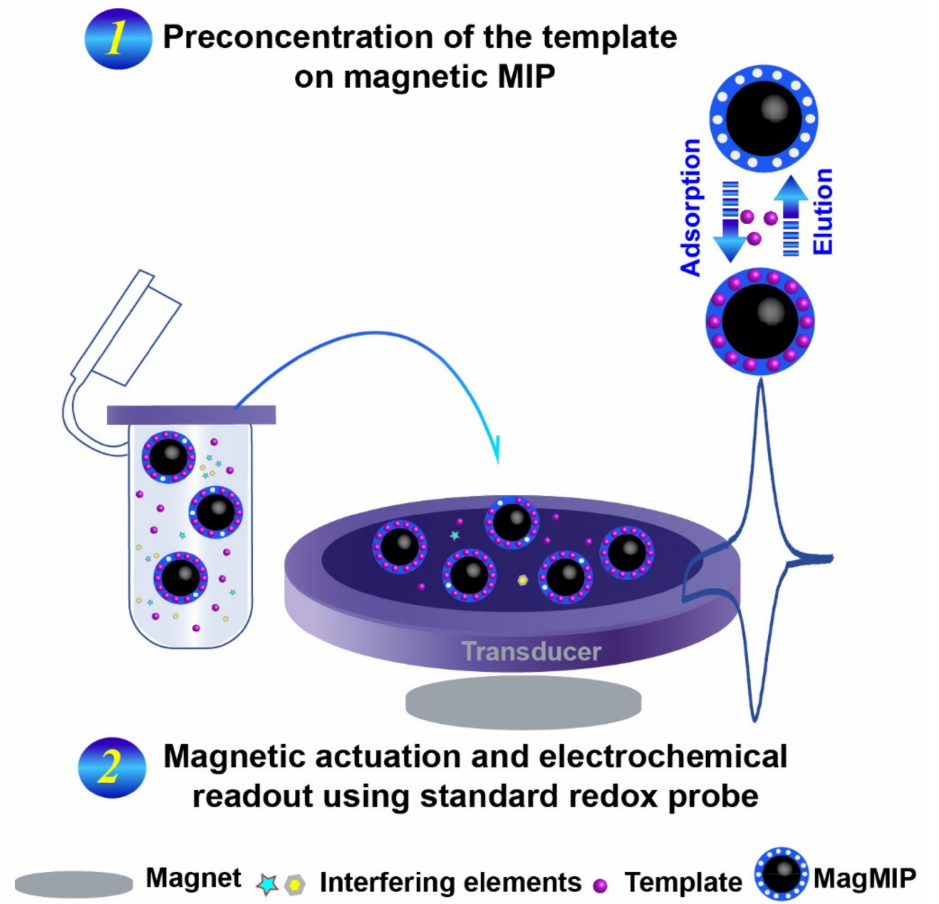
Figure 3. Schematic procedure for the electrochemical sensing of a target analyte preconcentrated on